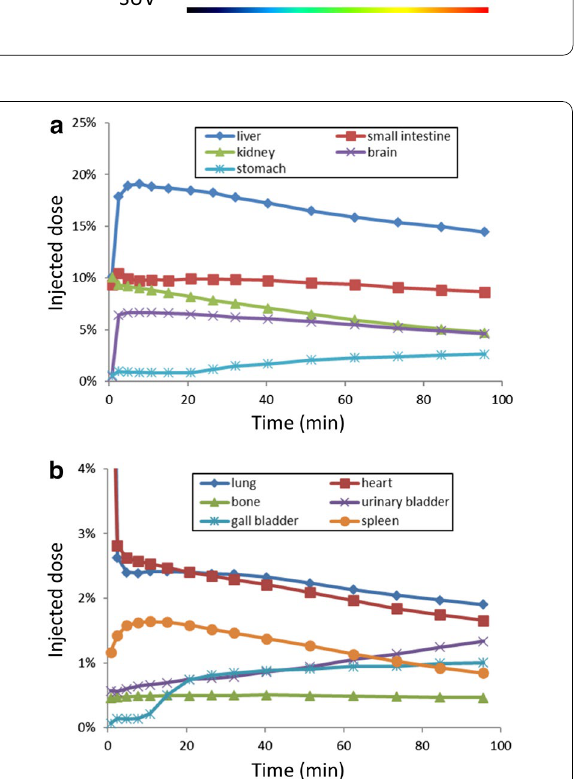
Fig. 7 Representative time activity curves of [ 11 C]PF-06809247 in a high accumulation organs and b low accumulation